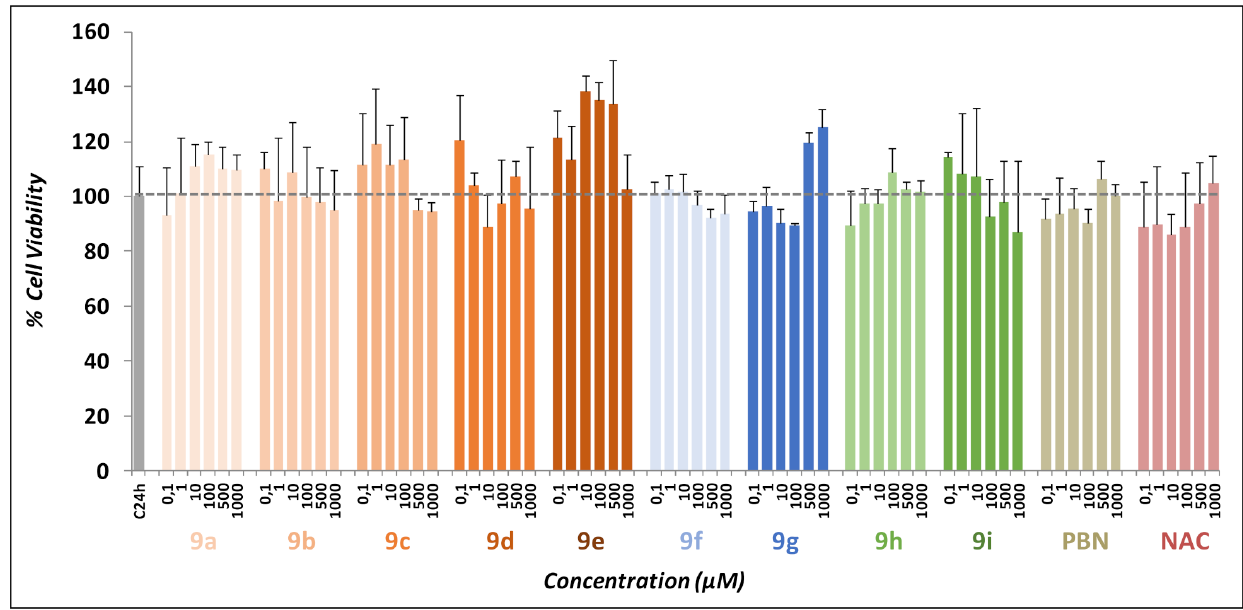
Figure 8. Effect of nitrones 9a – 9i , PBN , and NAC on human neuroblastoma SH-SY5Y cell viability under basal conditions. Bars show percent of cell viability in the presence of the compounds at the specified concentrations. The untreated cells (C24h) were considered 100% (100 ± 9.96%). Values represent the mean ± SEM of six experiments, performed in triplicate. Statistics was performed by one-way ANOVA test. There were no significant differences with respect to control. Analysis of results above 100% is not